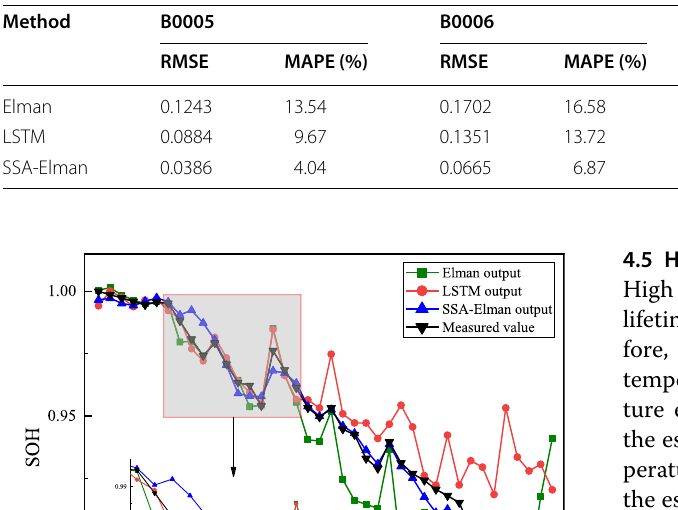
Table 9 The estimation error of 30% training data RMSE and MAPE